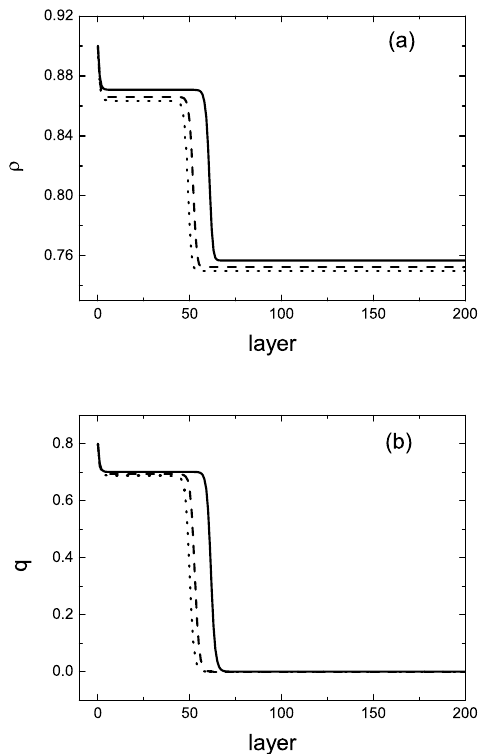
Figure 6. PS case. Effect of increasing chemical potential on profiles step for θ = 1.62. ( a ) occupancy and ( b ) orientational order parameter. Dotted line: a = 0.00, dashed line: a = 0.02 and continuous line a = 0.06.